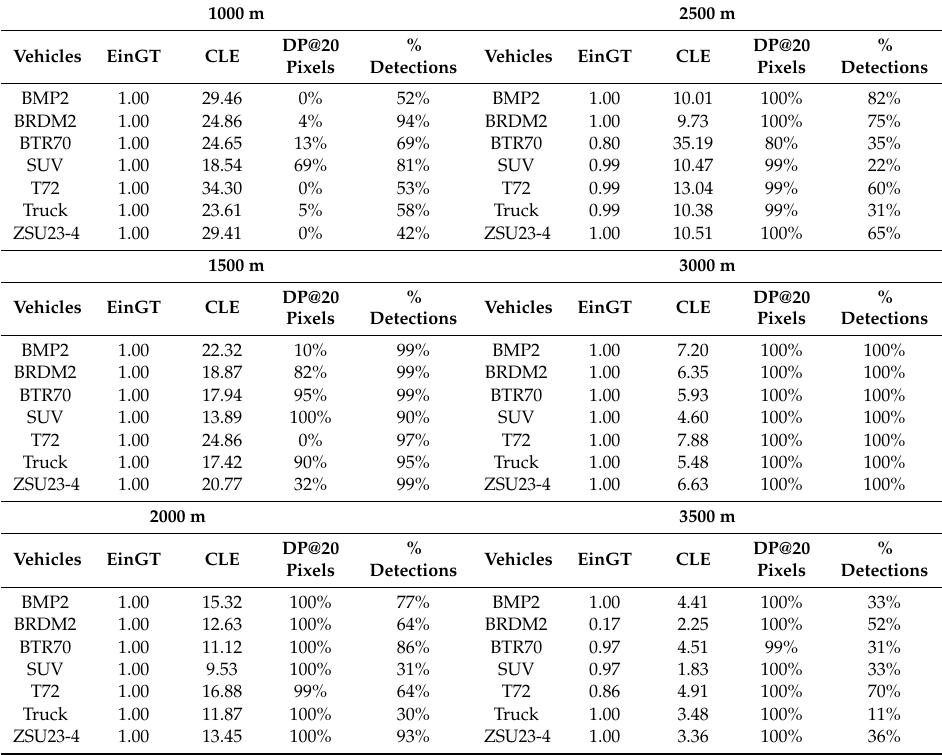
Table 5. Tracking metrics for PCE full (MWIR daytime) case. 1500 m and 3000 m were used for training. 1000 m 2500 m